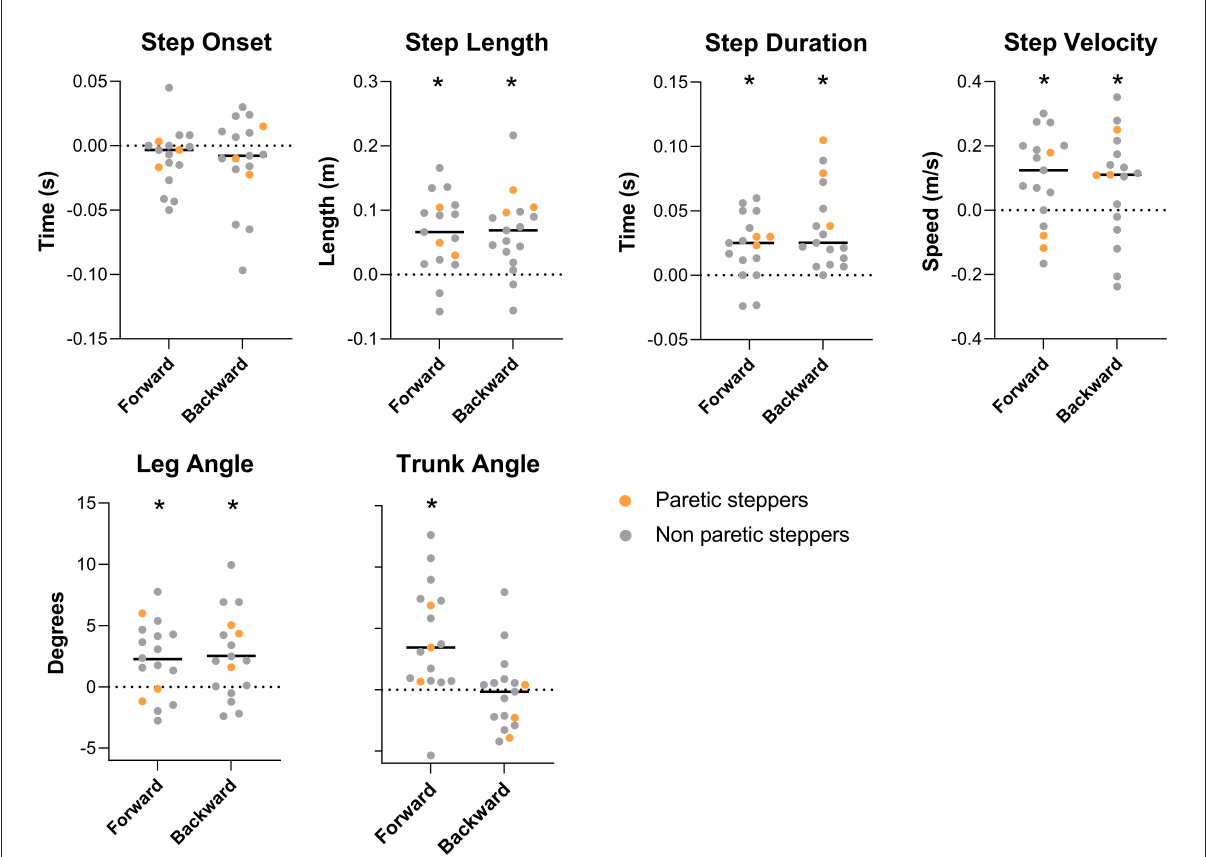
FIGURE2 Spatiotemporal and body configurational outcome effect of training. Outcome measures are expressed as pre-post training differences. Bars represent group average, dots represent individual data points; participants who stepped with the paretic leg are indicated as orange dots. * Represents a significant pre-post training difference ( P <